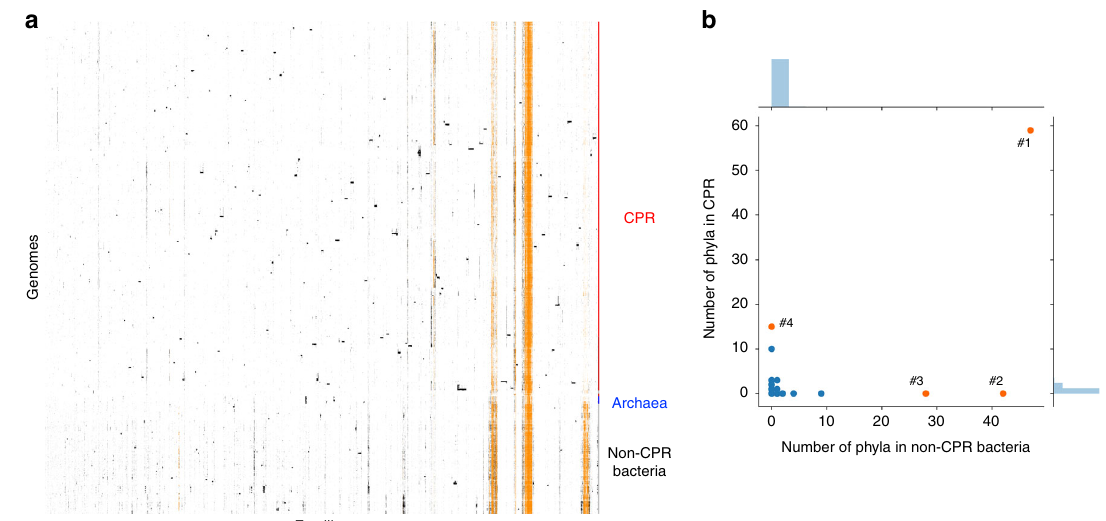
Fig. 2 The distribution of the 22,977 families across the 2890 genomes. a The distribution of the 22,977 families (columns) across the 2890 prokaryotic genomes (rows). Data are clustered based on the presence (black)/absence (white) pro fi les (Jaccard distance, hierarchical clustering using a complete linkage). Archaea: blue, CPR: red, non-CPR bacteria: gray. The patterns in orange correspond to the presence/absence patterns of 921 widespread families. b The phyla distribution of the 235 modules of proteins in CPR ( y axis) and non-CPR bacteria ( x axis). Each dot corresponds to a module. The orange dots correspond to the four widespread modules on which further analyses